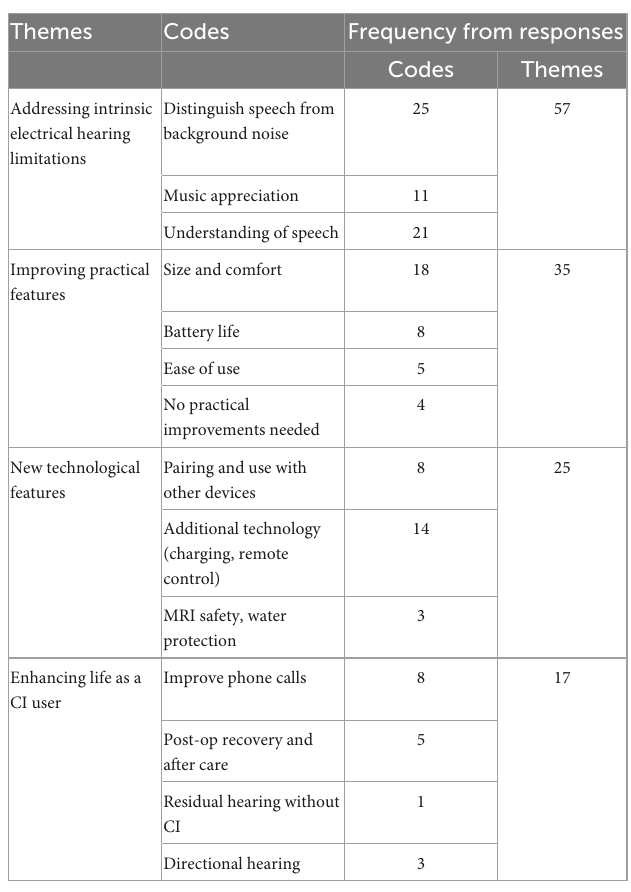
TABLE 3 Themes and codes of participants’ open text responses to features desired in a new cochlear implant